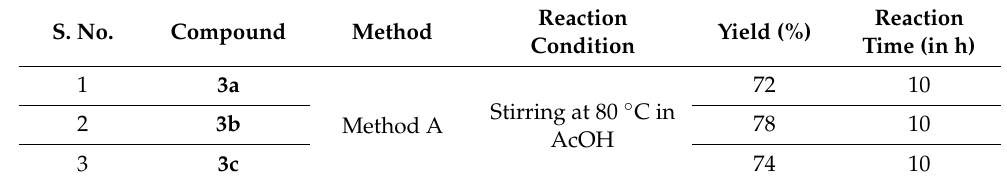
Table 1. The percentage yield and reaction time for the synthesis of curcumin analogues ( 3a–c ). S. No.